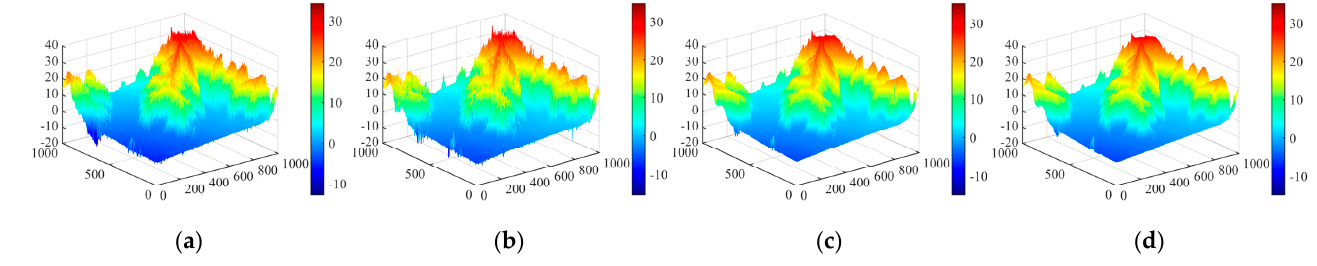
Table 2. The evaluation results of different methods on TerraSAR-X/TanDEM-X data.